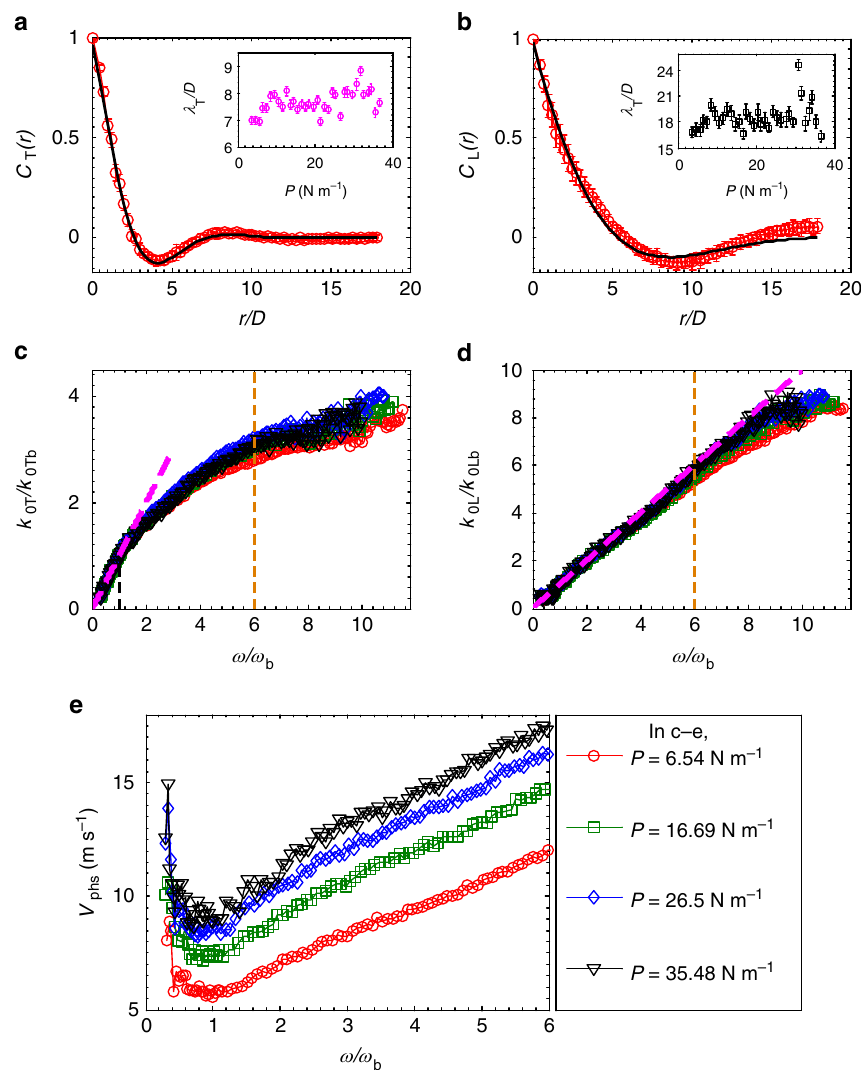
Fig. 5 Dispersion relations of T and L waves. a , b Autocorrelation functions of the polarization vectors: C T,L ( r ) of the transverse (T) and the longitudinal (L) waves. Here, the pressure P = 26.5 N m − 1 , and C T,L ( r ) is ensemble averaged. The black lines denote fi ttings based on the function C ( r ) = e − Γ r 2 cos( kr + ϕ ), where k , Γ , and ϕ are three fi tting parameters. Insets: wavelengths λ T,L = 2 π at ω = ω b vs. pressure. The error bars in a , b and their insets denote k 0 T ; L one SD around the mean value obtained from ∼ 10 realizations of each pressure. c , d Dispersion relations at pressures of (units N m − 1 ) P = 6.54 ffiffiffiffiffiffiffiffiffiffiffiffiffiffiffiffiffiffiffiffiffiffiffiffiffiffiffi q þ Γ 2 = 4 ( red circles ),16.69 ( green squares ), 26.5 ( blue diamonds ), and 35.48 ( black inverted triangles ). Here, k 0T ; L ¼ k 2 . The dashed magenta line T ; L T ; L k 0T,L / k 0T,Lb = ω / ω b is used as a guide. The dashed orange line at ω / ω b = 6 represents the starting point of the Anderson localizations, and hence, the dispersion relation is no longer applicable. e Phase velocities V phs ≡ ( ω )/( k 0T ) of T waves show a prominent dip near BP frequency ω b at four corresponding pressures; the actual positions of these dips are at ω / ω b = 0.960, 0.954, 0.915, and 0.919 from bottom to top. To locate each dip, we use a fourth-order polynomial to reduce the noise and fi t the data. Here c – e are ensemble averaged for ∼ 10 realizations of each pressure,and the error bars are within the symbol ~ indentation modulus, which is a combination of both bulk and indicating the important role of δ G in the formation of the BP. ~ ~ shear moduli, obeys a Gaussian distribution with must larger Indeed, δ G and δ B vs. the coarse-graining length w satisfy the fl uctuations than those of the crystal 52 . The Gaussian distribution power law fi tting similar to refs. 50, 51 , as shown in Fig. 6(c). ~ ~ B / w (cid:2) 1 : 11 in Fig. 6(c), where- Quantitatively, δ G / w (cid:2) 0 : 81 and δ derived from Wagner et al. ’ s experiment 52 is consistent with the ~ ~ B / w (cid:2) 1 : 13 as shown in Supplementary as both δ G / w (cid:2) 1 : 02 and δ results shown in Fig. 6(c) and Supplementary Fig. 5, revealing Fig. 5. These fi ndings are consistent with refs. 50, 51 . Here the w − 1 universal Gaussian statistics of local modulus fl uctuations in 2D scaling can be understood based on the central limit theorem and and 3D glassy systems that are independent of dimensions and the lack of long-range correlations in the spatial fl uctuations detailed particle-scale interactions. of moduli, equivalent to Gaussian statistics of the modulus fl ucutation 31, 50, 51 . In a recent experiment, Wagner et al. used a regime fi rst appears in the spatial distribution of G as the coarse- novel atomic force acoustic microscopy method to measure the graining size w decreases. Figure 6(d) plots the percentage of the distribution of local elastic constants along the surface of metallic negative G as a function of w at different pressure levels. The fi rst glass 52 . Their results revealed that the distribution of a local negative modulus appears at ~ w = 7 D for all pressure levels, and